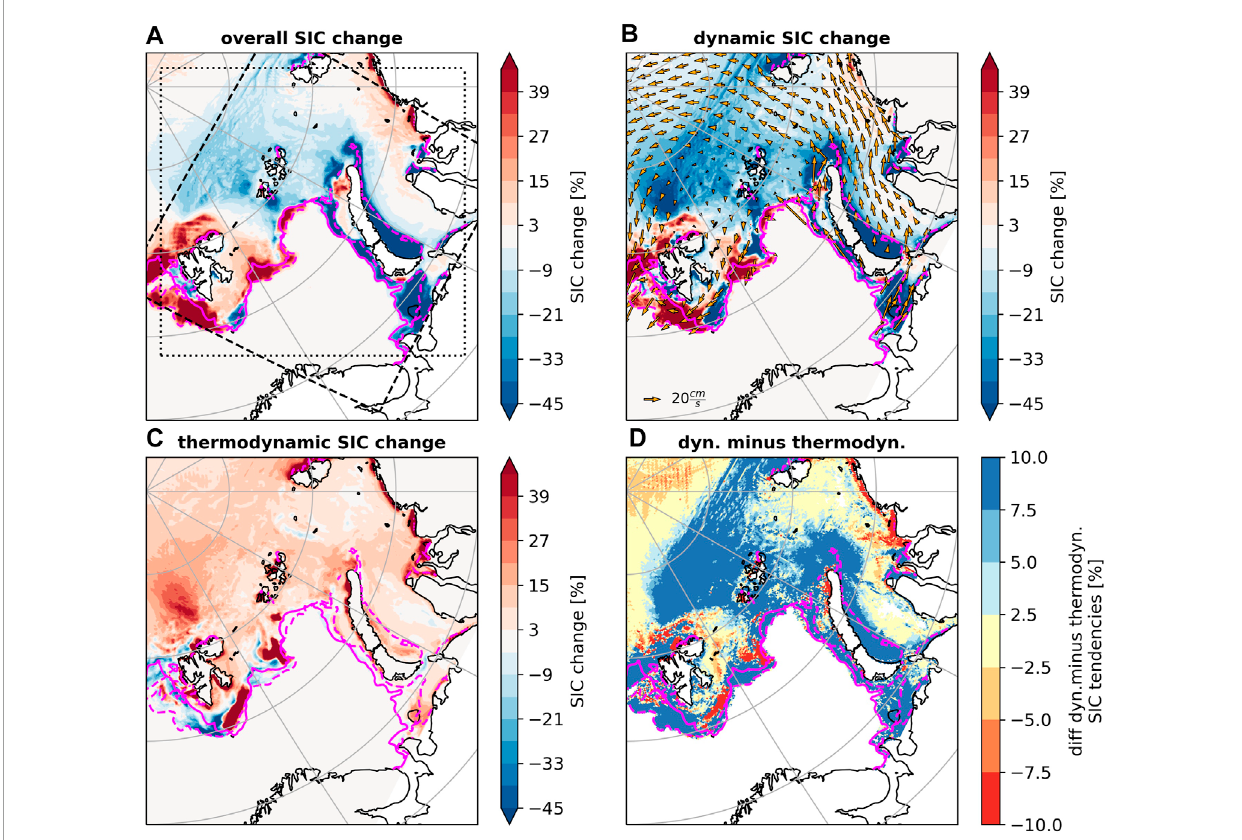
FIGURE 4 Overall SIC change during the whole sequence of cyclones (9.2.20-25.2.2020) (A) , temporally integrated dynamic (advective plus rafting and ridging) SIC change as well as mean sea ice drift vectors (B) , temporally integrated thermodynamic SIC change (C) , and difference between absolute values of temporally integrated dynamic and thermodynamic SIC change (D) based on the HIRHAM–NAOSIM simulation. Solid (dashed) pink lines indicate the position of the ice edge (15% SIC) on 9.2.2020 (25.2.2020). Dashed (dotted) box in (A) indicates domain of spatially averaged SIC (SLP) changes in Section 3.5